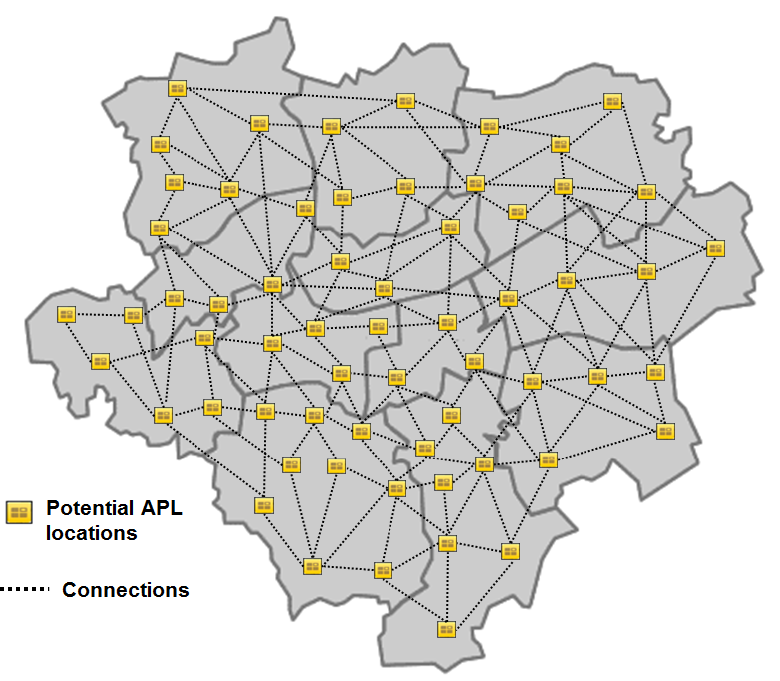
Figure 7. Illustrative CFLP for APLs in the city of